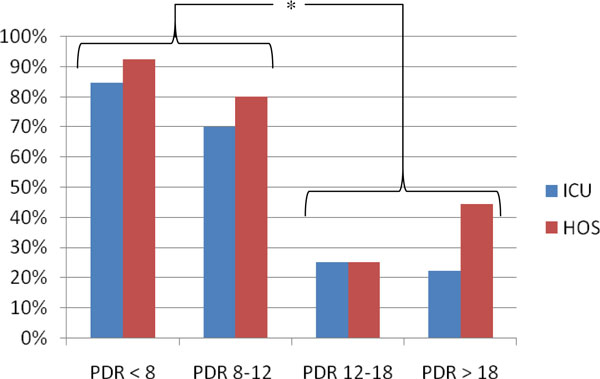
ICU and hospital mortality according to PDRICG category. The asterisk indicates a p value of 0.006 comparing ICU and hospital (HOS) outcome in the group of patients with a PDRICG below and higher than 12%.